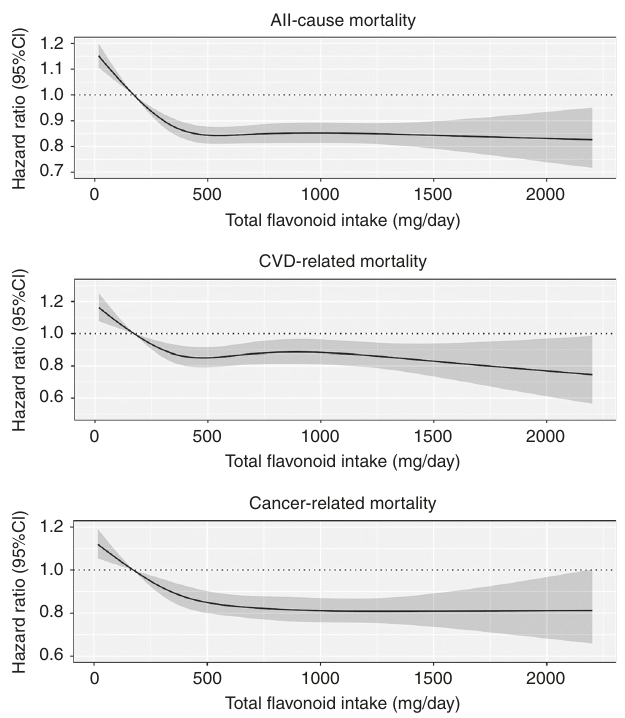
Fig. 1 The association of total fl avonoid intake with all-cause and cause- speci fi c mortality. Hazard ratios are based on Cox proportional hazards models adjusted for age, sex, BMI, smoking status, physical activity, alcohol intake, hypertension, hypercholesterolemia, social economic status (income), and prevalent disease and are comparing the speci fi c level of fl avonoid intake (horizontal axis) to the median intake for participants